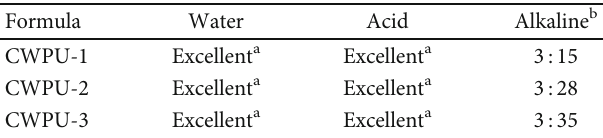
Table 6: Water, acid, and alkaline resistance of cationic waterborne polyurethane (CWPU) fi lms with various internal emulsi fi